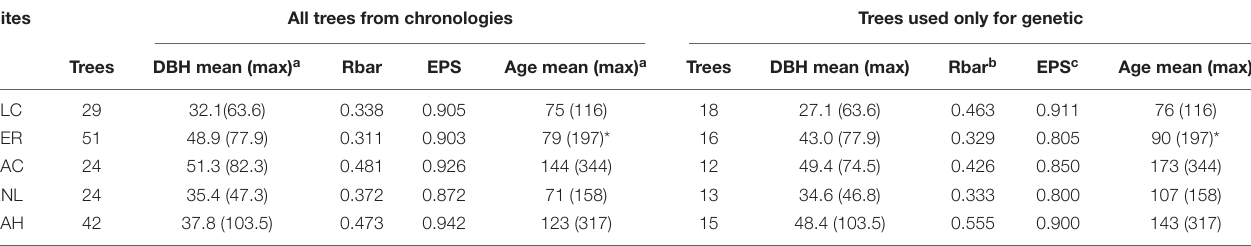
TABLE 1 | Main characteristics of the sampled populations. Sites All trees from